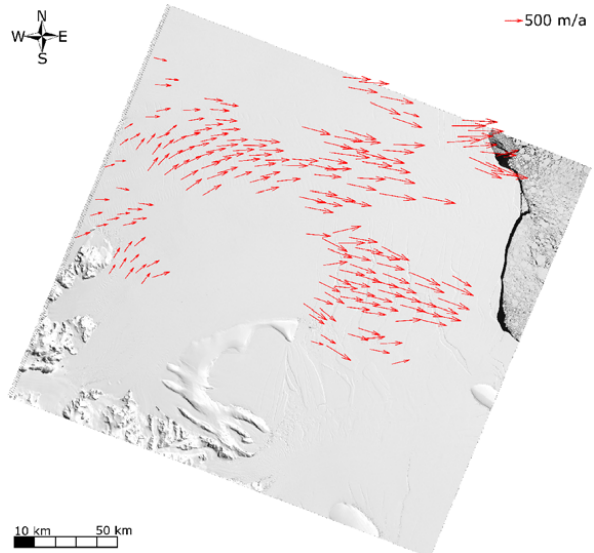
Fig. 7. Average annual velocity between 2006 and 2009 measured with orientation correlation on Landsat 7 ETM+ pan images from path 216 row 108 over Larsen C South. Underlying Landsat image of 2002.